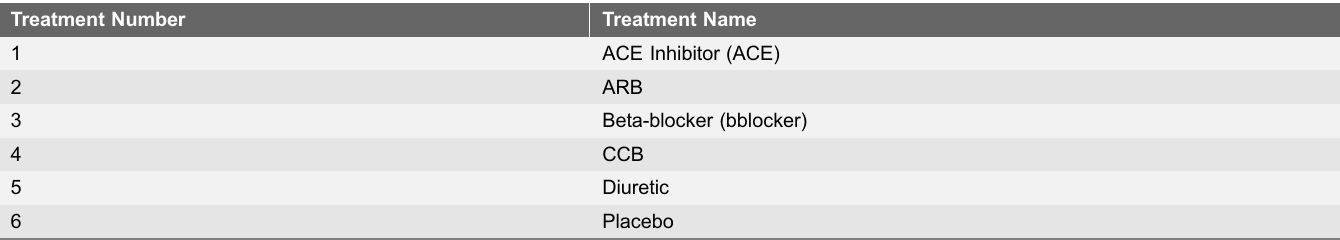
Table 5. List of Treatment Reference Numbers for Diabetes